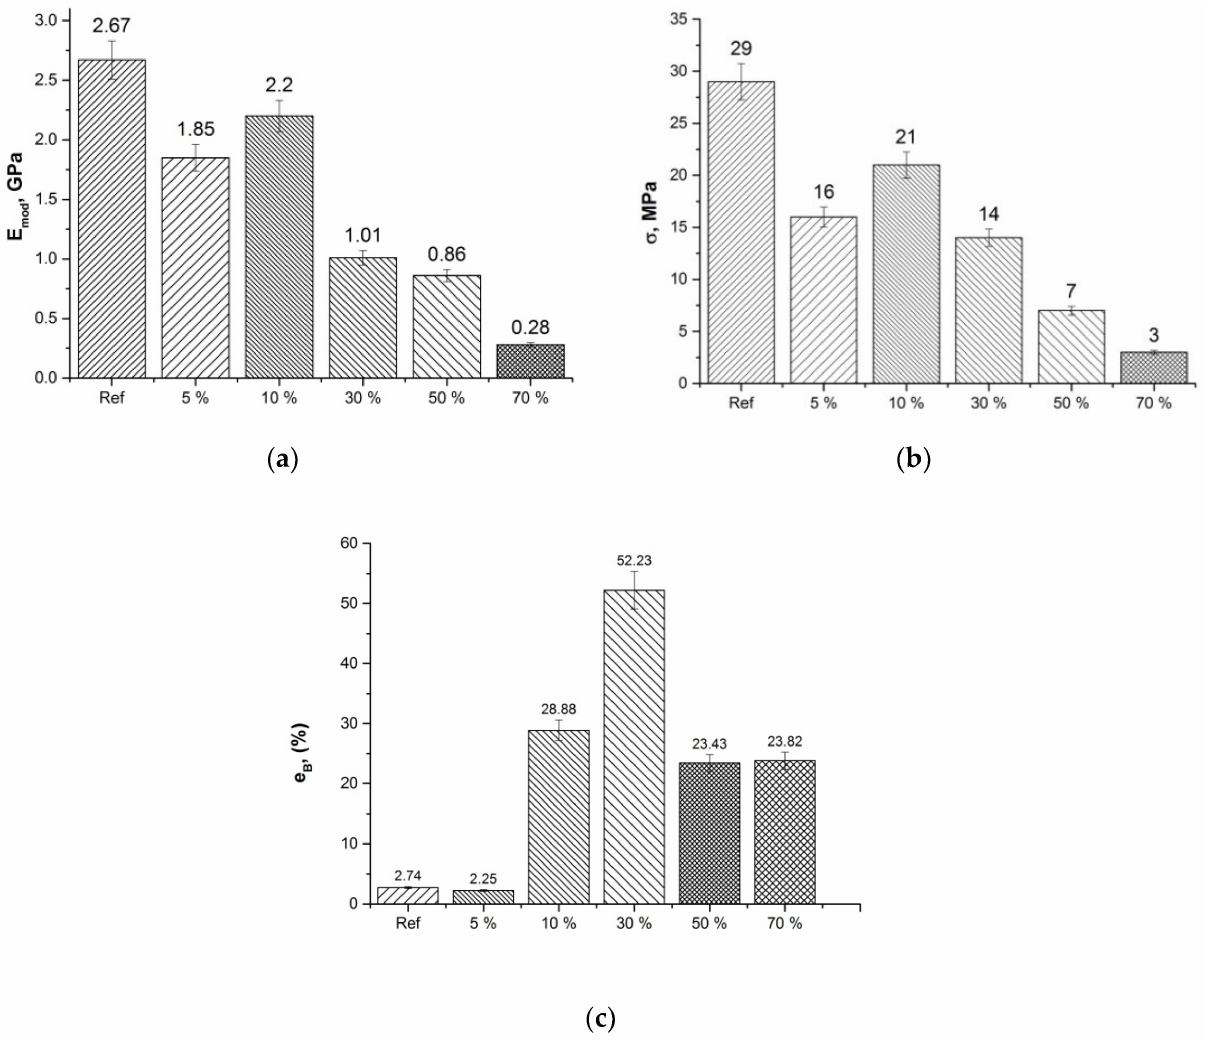
Figure 5. Elastic modulus ( a ), tensile strength ( b ), and relative elongation at break ( c ) for pristine PLA and PLA + OTOA film